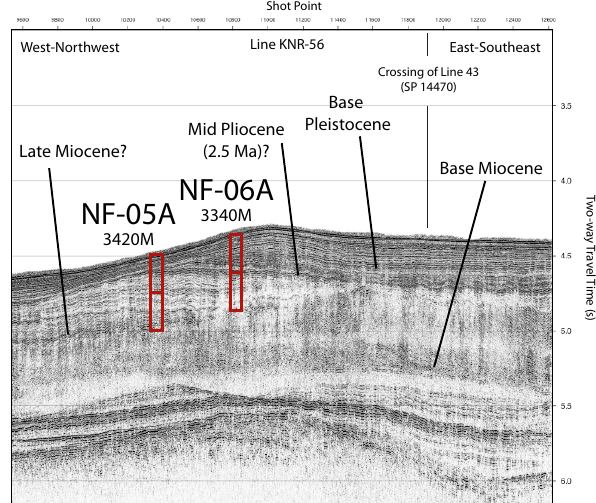
Figure 2. Example of seismic line showing the Miocene drilling target as it appears in seismics at the SE Newfoundland ridges. Two proposed drill sites (NF-05A and NF-06A) are shown for visual- ization. Red bars indicate a penetration depth of 500m below sea